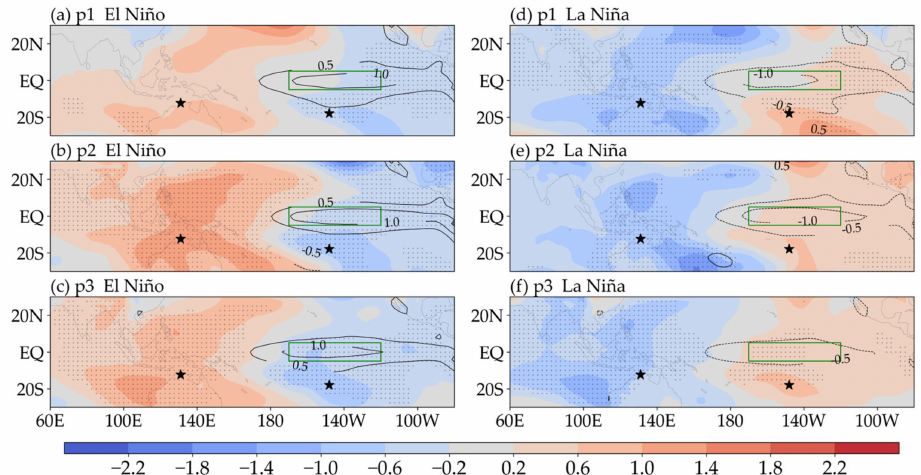
Figure 2. Composite results of SST anomalies ( ◦ C; isoline) and sea level pressure (SLP) anomalies (hPa; shade) averaged over December–February of ENSO in three periods during 1955–2020, namely, boreal winters of El Niño events ( a ) 1957, 1963, 1965, 1968, 1972, 1976, ( b ) 1977, 1979, 1982, 1986, 1991, 1994, 1997, ( c ) 2002, 2004, 2006, 2009, 2015, 2018, 2019, and boreal winters of La Niña events ( d ) 1955, 1964, 1970, 1973, 1975, ( e ) 1984, 1988, 1995, ( f ) 1999, 2000, 2007, 2010, 2011, 2017, 2020. The SST and SLP retain ENSO signals for 2–7 years by band-pass filtering. The black solid (dashed) isolines represent positive (negative) SST anomalies. The p1, p2, and p3 are the same as in Figure 1. The green box is the Niño-3.4 region. The left and right asterisks in each subfigure show the locations of the Darwin and Tahiti stations, respectively. Light black dots indicate that the composite results pass the Student t -test with a confidence level of 95%.